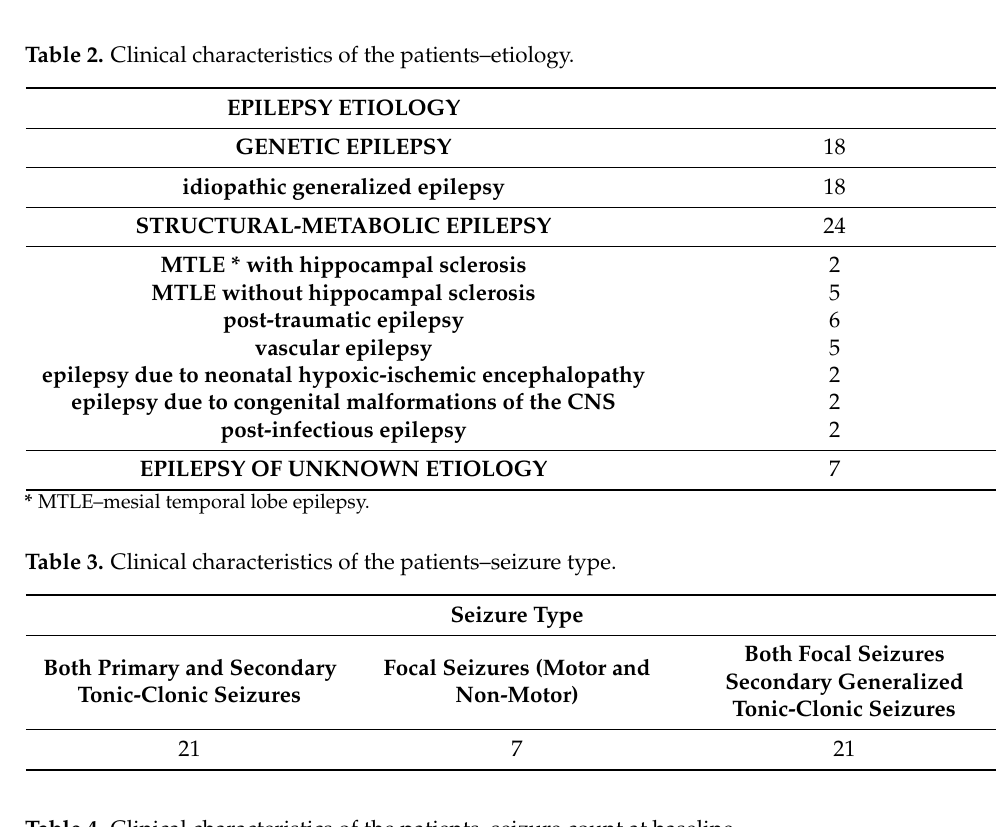
Table 4. Clinical characteristics of the patients–seizure count at baseline.